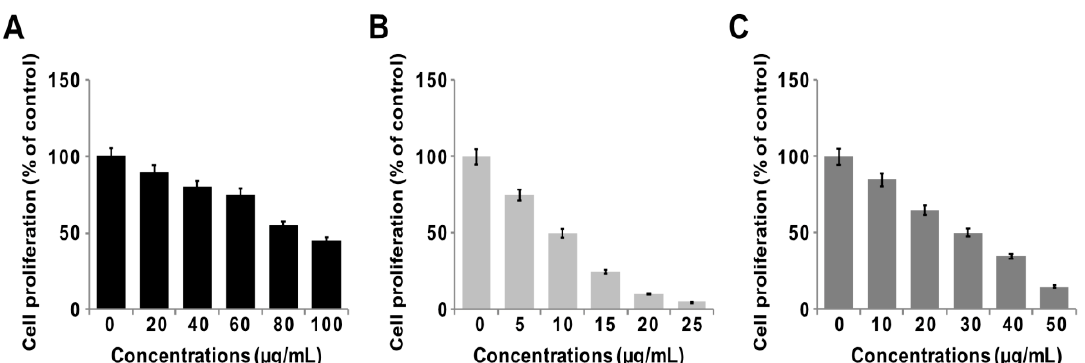
Figure 7. GO, GO-PtNPs, and PtNPs inhibit cell proliferation of LNCaP cells. Cell proliferation of LNCaP cells was determined using BrdU assay after 24-h exposure to different concentrations of GO ( A ), GO-PtNPs ( B ), and PtNPs ( C ). The treated groups showed statistically significant differences from the control group by the Student’s t -test (* P < 0.05).